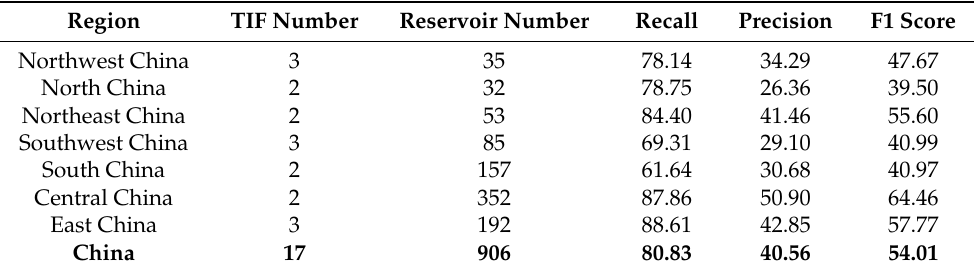
Table 3. Detection results of the two-stage recognition algorithm in our constructed dataset with labels in seven national geographic regions.